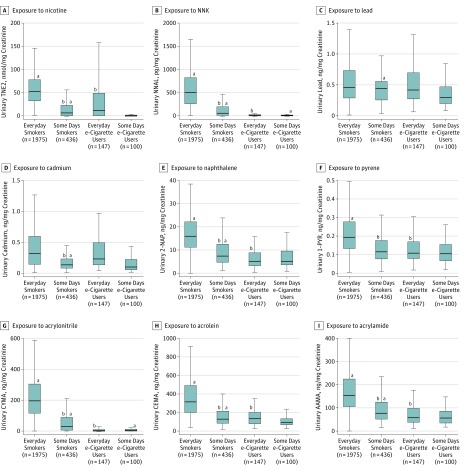
Biomarkers of Exposure Among e-Cigarette–Only Users and Cigarette-Only Smokers, Stratified by Everyday or Some-Days Product Use, Population Assessment of Tobacco and Health Study, Wave 1, 2013-2014 (n = 2658)Exposure to nicotine (TNE2) (A), tobacco-specific nitrosamine 4-(methylnitrosamino)-1-(3-pyridyl)-1-butanone (NNK) (B), lead (C), cadmium (D), naphthalene (2-naphthol) (2-NAP) (E), pyrene (1-hydroxypyrene) (1-PYR) (F), acrylonitrile (CYMA) (G), acrolein (CEMA) (H), and acrylamide (AAMA) (I). All analyses are weighted. Some volatile organic compound laboratory results were outstanding at the time these analyses were conducted, so weighted estimates may not accurately reflect values in the target population. Everyday e-cigarette users reported yes to current daily use of e-cigarettes, no to current everyday/some-day use of all other tobacco products; some-days e-cigarette users reported yes to current some-days use of e-cigarettes, no to current everyday/some-days use of all other tobacco products; everyday smokers reported yes to current daily use of cigarettes, no to current everyday/some-days use of all other tobacco product; some-days smokers reported yes to current some days use of cigarettes, no to current everyday/some-days use of all other tobacco products. All user groups reported no past 3-day use of nicotine replacement therapies. Box depicts median (interquartile range); whiskers depict minimum and maximum values for creatinine-corrected biomarker across tobacco user groups. Outliers excluded from figure to facilitate presentation clarity.aStatistically significant difference with everyday e-cigarette users based on results from adjusted linear regression models (P < .05). Comparisons were performed for everyday smokers with everyday e-cigarette users, everyday smokers with some-days smokers, everyday e-cigarette users with some-days smokers, and everyday e-cigarette users with some-days e-cigarette users.bStatistically significant difference with everyday smokers based on results from adjusted linear regression models (P < .05).